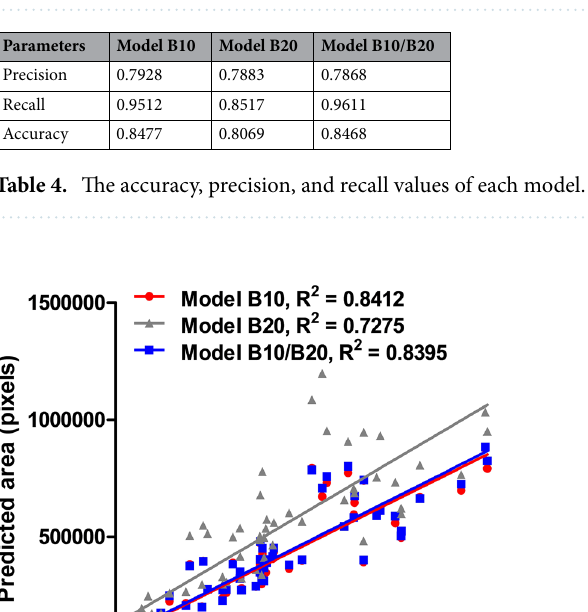
Figure 5. Model prediction results on the test dataset of its own and other datasets for the effect of staining tones.